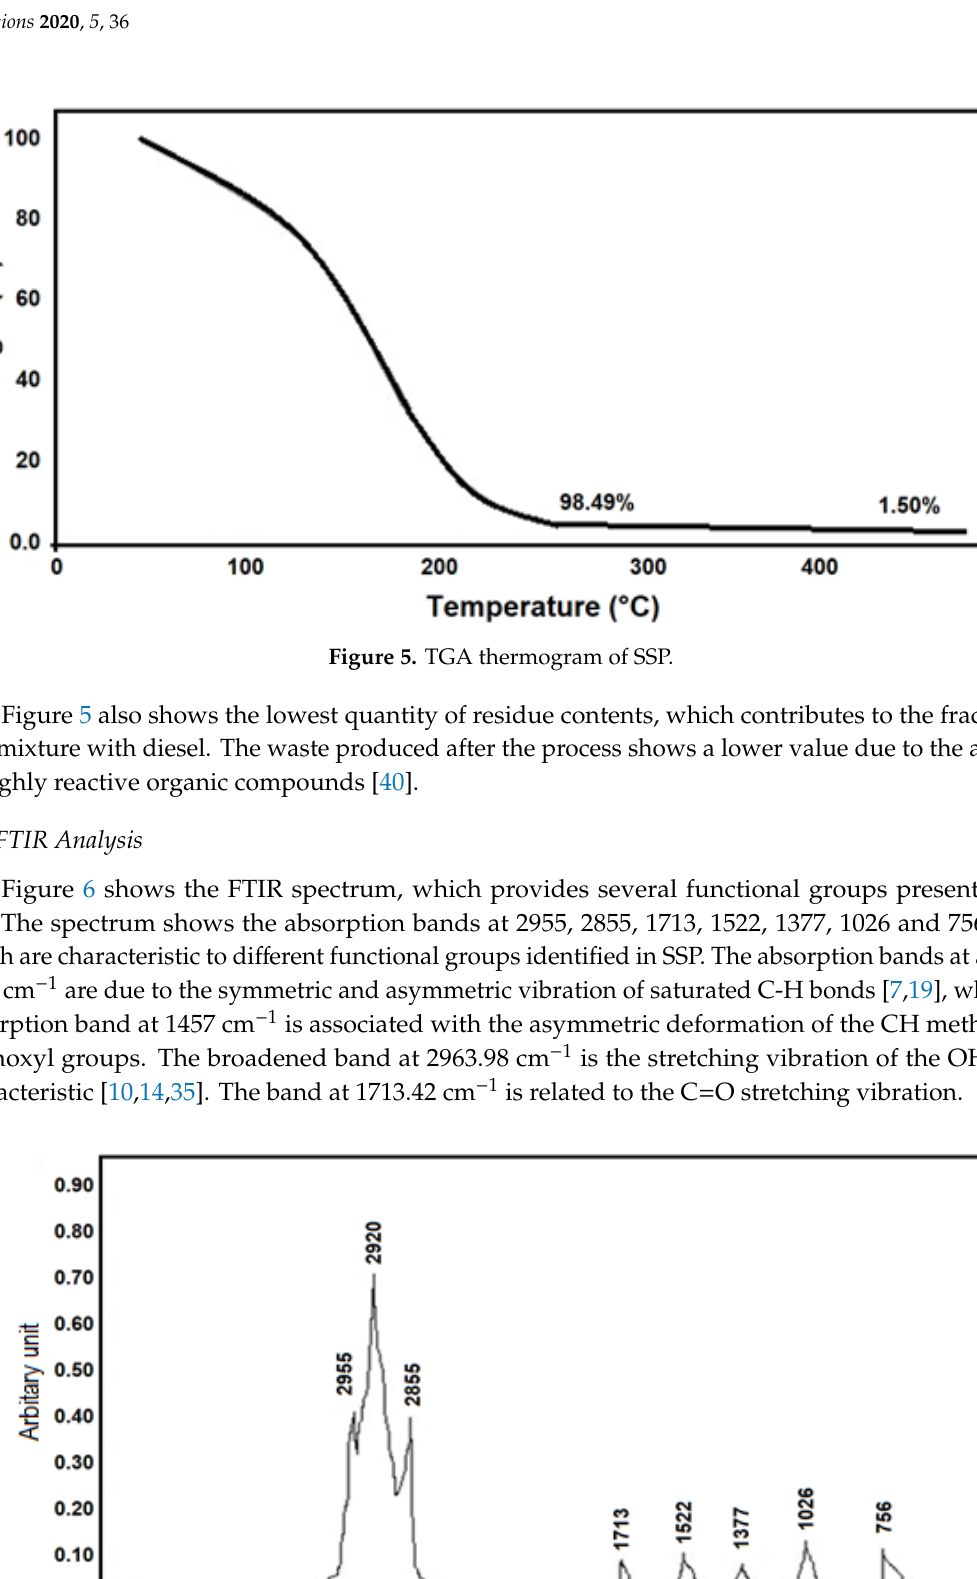
Figure 6. Fourier transform infrared (FTIR) spectra of functional groups identified in SSP.